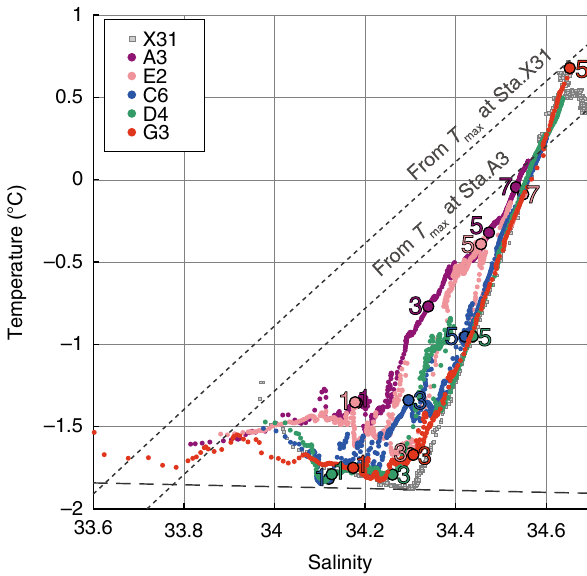
Fig. 4 Glacial meltwater signals on δ 18 O-S space. δ 18 O (the stable oxygen isotope ratio)-salinity relationships at fi ve trough stations (colored circles with numbers showing the pressure where water samples were obtained), ice front stations (purple symbols), and mouth of LHB (red symbols). Two dashed lines extending from “ mCDW ” denote lines connecting two endmembers of “ mCDW ” with “ glacier ” and “ sea ice ” , respectively. Note that δ 18 O-salinity relationships for “ glacier ” and “ sea ice ” endmembers are beyond the range of plot.